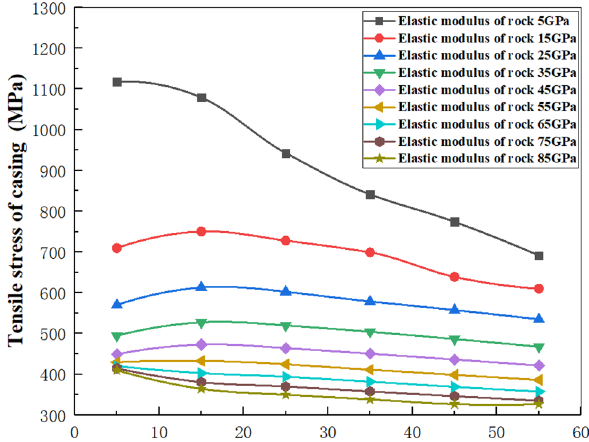
Fig. 16 Variation curve of casing tensile stress with Young’s modulus of elasticity of cement versus different Young’s modulus of elasticity of rock